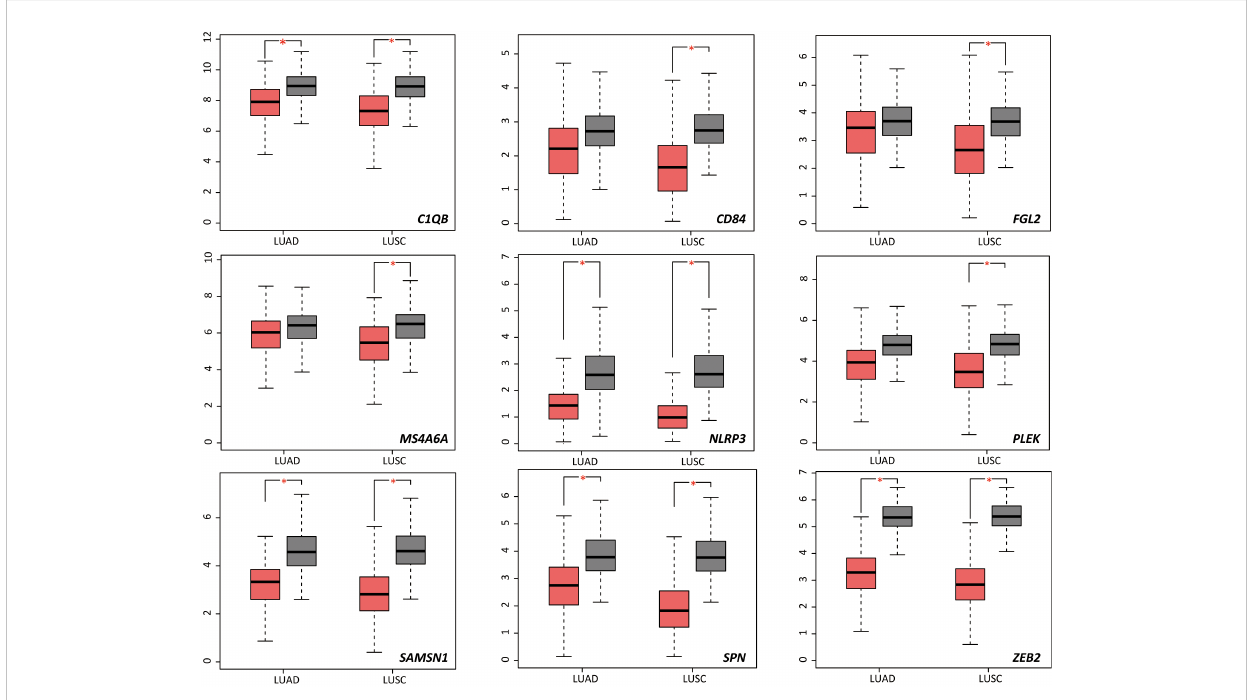
FIGURE 5 Differential expression analysis of 13 DRGs in lung squamous cell carcinoma and lung adenocarcinoma samples. DRGs, Differentiation Related Genes; LUAD, lung adenocarcinoma; LUSC, lung squamous cell carcinoma; T, tumor; N, non-tumor. *P < 0.05.